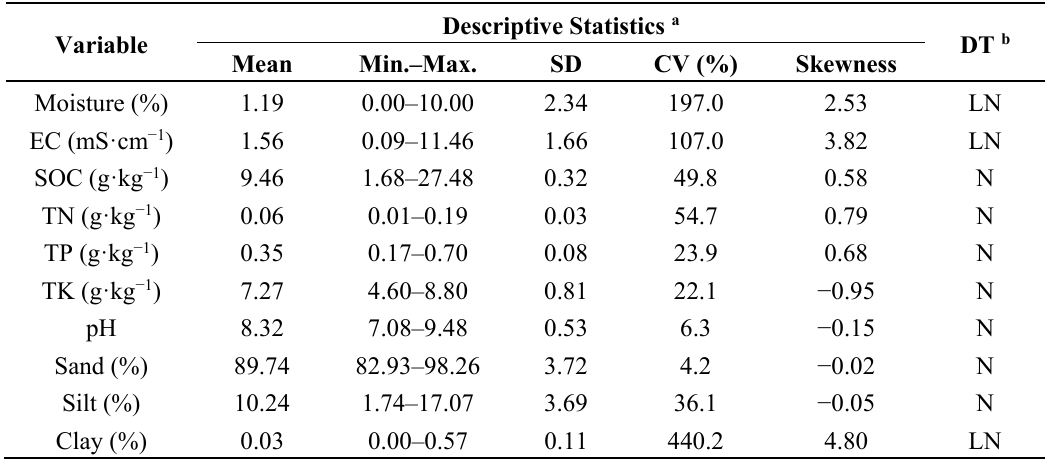
Table 1. Statistical summary for selected soil physical and chemical